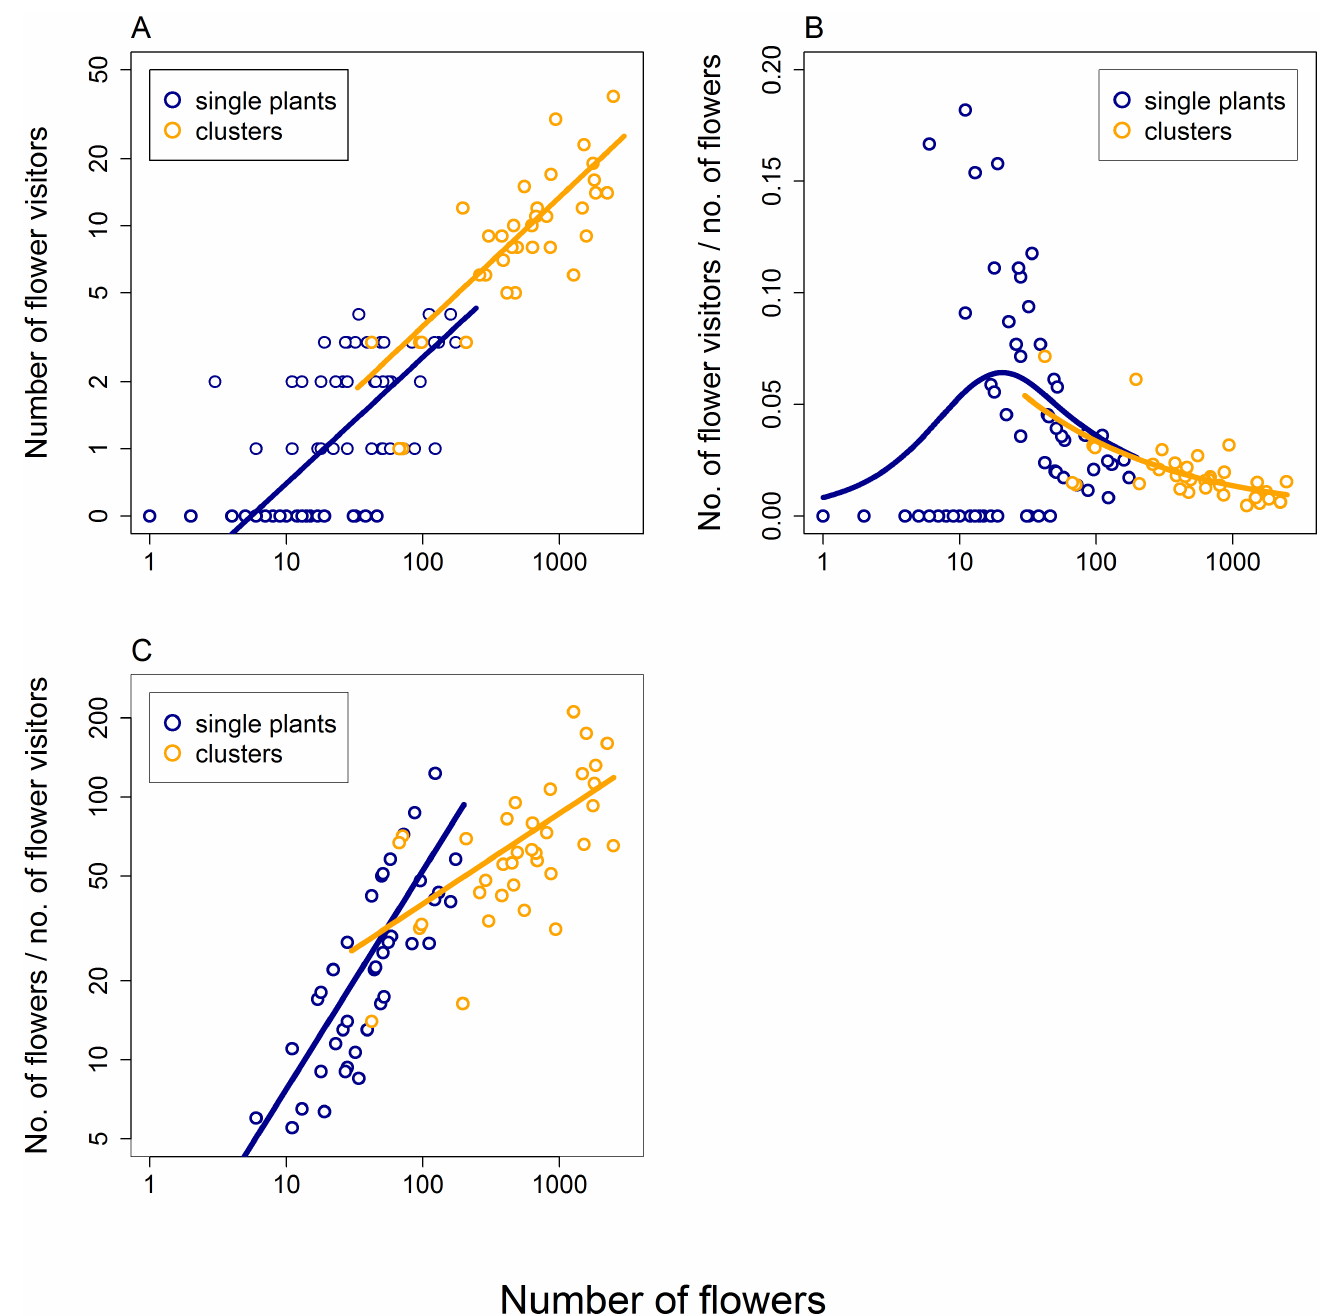
Fig 1. The effectsof the number of flowers in single plants and larger clusters on visitation by insects. The plots combinedata from two separatelyconducted experiments: one with single plants differing in the number of flowers (blue circles and fitted lines) and another with larger clusters of up to 36 plants (orange circles and fitted lines). Data from these two experiments were combinedfor the purposeof visualisation, but were analysed separately.A: The number of flower visitors observedduring30 minute observation periods on single plants and larger clusters varyingin the number of flowers. B: The number of insects visiting the plants or clusters of multipleplants relativeto the numberof flowers available.C: The numberof flowers availableper visitor; i.e. the potentialpay-off for the flower visitors.